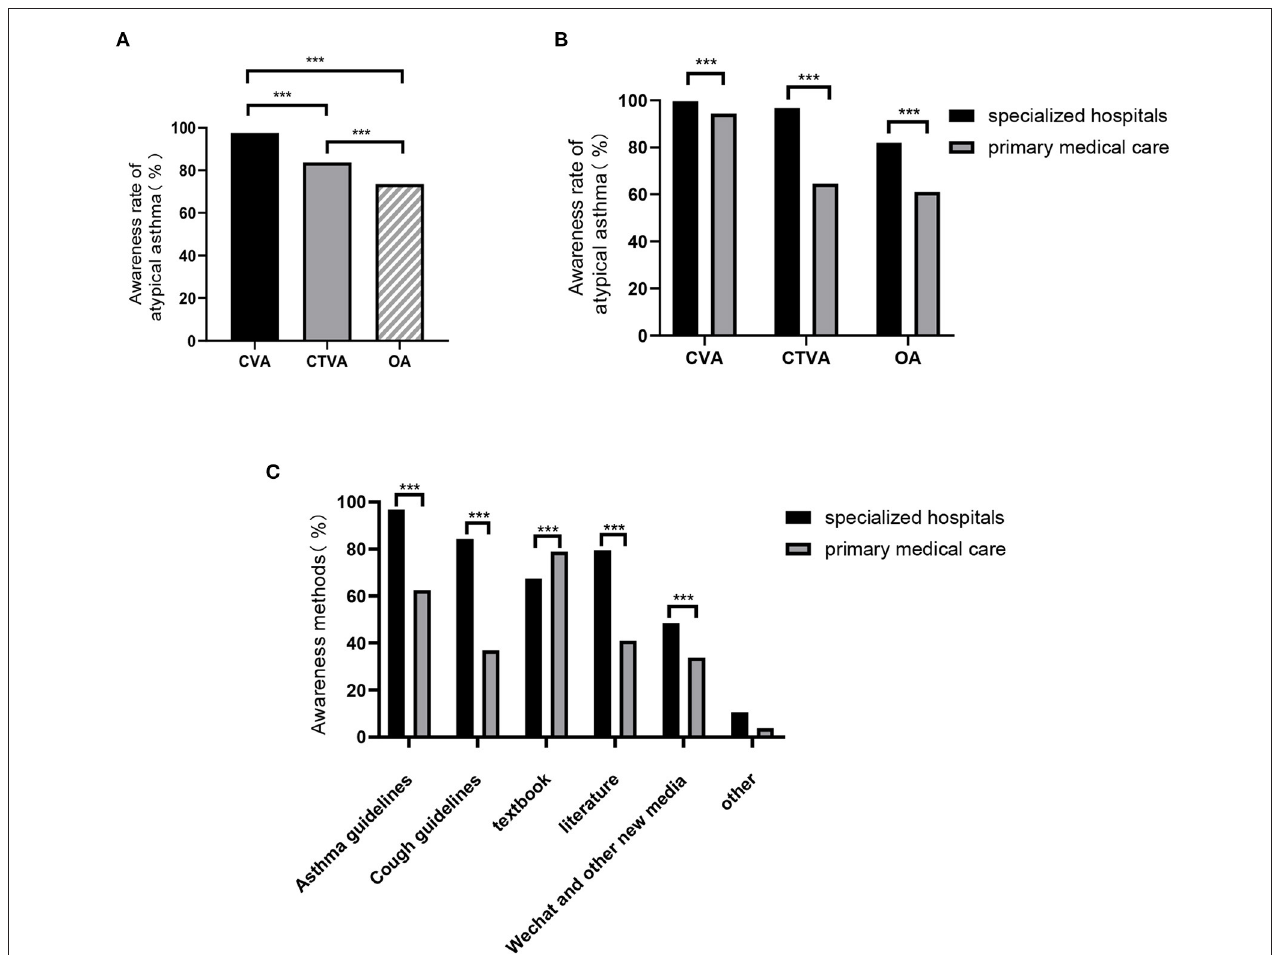
FIGURE 1 | Knowledge/awareness of atypical asthma. (A) Awareness of atypical asthma, including CVA, CTVA, and OA, among physicians in both specialized hospitals and primary medical care facilities. Awareness rates of atypical asthma (B) and Awareness methods of atypical asthma (C) between physicians in specialized hospitals and primary medical care facilities. CVA, cough variant asthma; CTVA, chest tightness variant asthma; OA, occult asthma. *** P <